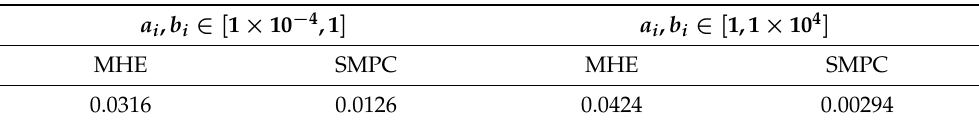
Table 3. Relative error (%) of performing secure batch division where numerators ( a i ) and denomina- tors ( b i ) are randomly chosen from various